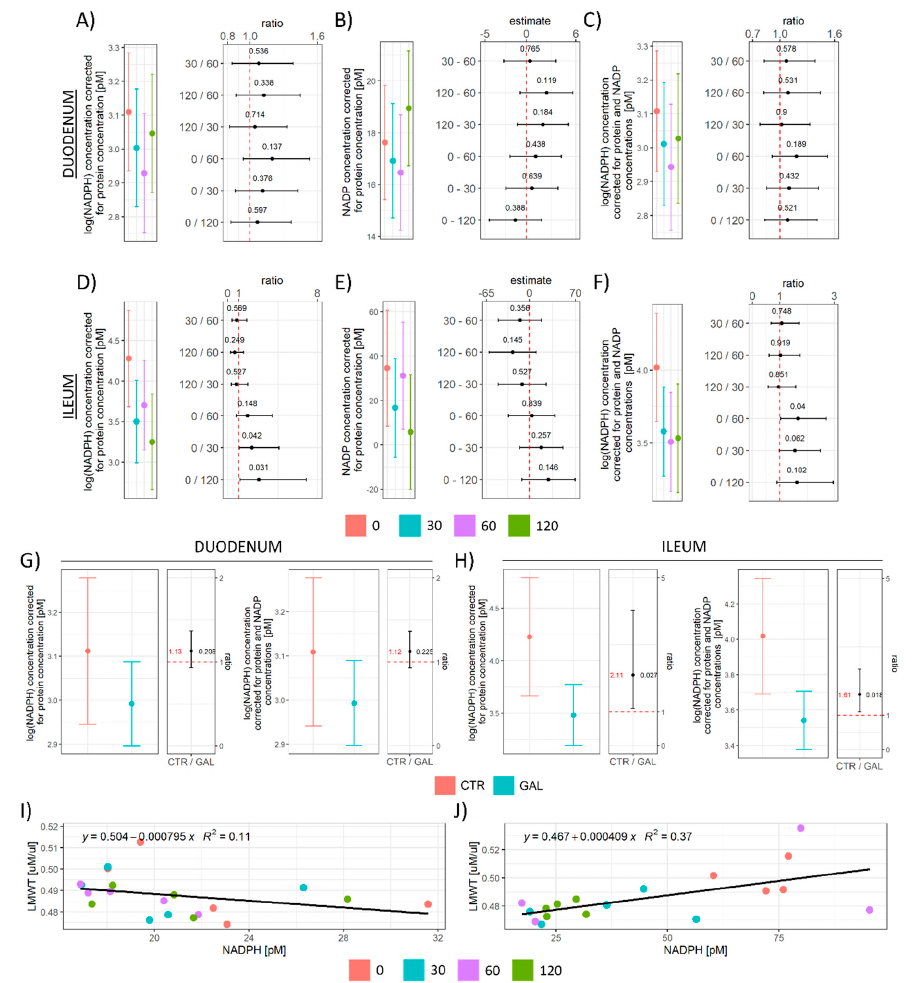
Figure 3. The concentration of reduced and oxidized nicotinamide adenine dinucleotide phosphates (NADPH and NADP) in the rat duodenum and ileum following acute orogastric gavage of 200 mg/kg D -galactose. ( A ) Duodenum NADPH model output (group point estimates with 95% confidence intervals) ( left ) and ratios of estimated marginal means for groups with corresponding 95% confidence intervals ( right ). ( B ) Duodenum NADP model output (group point estimates with 95% confidence intervals) ( left ) and differences of estimated marginal means for groups with corresponding 95% confidence intervals ( right ). ( C ) Duodenum NADPH corrected for the cellular pool of NADP. Model output (group point estimates with 95% confidence intervals) ( left ) and ratios of estimated marginal means for groups with corresponding 95% confidence intervals ( right ). ( D ) Ileum NADPH model output (group point estimates with 95% confidence intervals) ( left ) and ratios of estimated marginal means for groups with corresponding 95% confidence intervals ( right ). ( E ) Ileum NADP model output (group point estimates with 95% confidence intervals) ( left ) and differences of estimated marginal means for groups with corresponding 95% confidence intervals ( right ). ( F ) Ileum NADPH corrected for the cellular pool of NADP. Model output (group point estimates with 95% confidence intervals) ( left ) and ratios of estimated marginal means for groups with corresponding 95% confidence intervals ( right ). ( G ) Duodenum log(NADPH) pooled treatment effect model output (group point estimates with 95% confidence intervals) with ratios of estimated marginal means for treatments with corresponding 95% confidence intervals ( left ). Duodenum log(NADPH) pooled treatment effect corrected for the cellular pool of NADP. Model output (group point estimates with 95% confidence intervals) with ratios of estimated marginal means for treatments with corresponding 95% confidence intervals ( right ). ( H ) Ileum log(NADPH) pooled treatment effect model output (group point estimates with 95% confidence intervals) with ratios of estimated marginal means for treatments with corresponding 95%